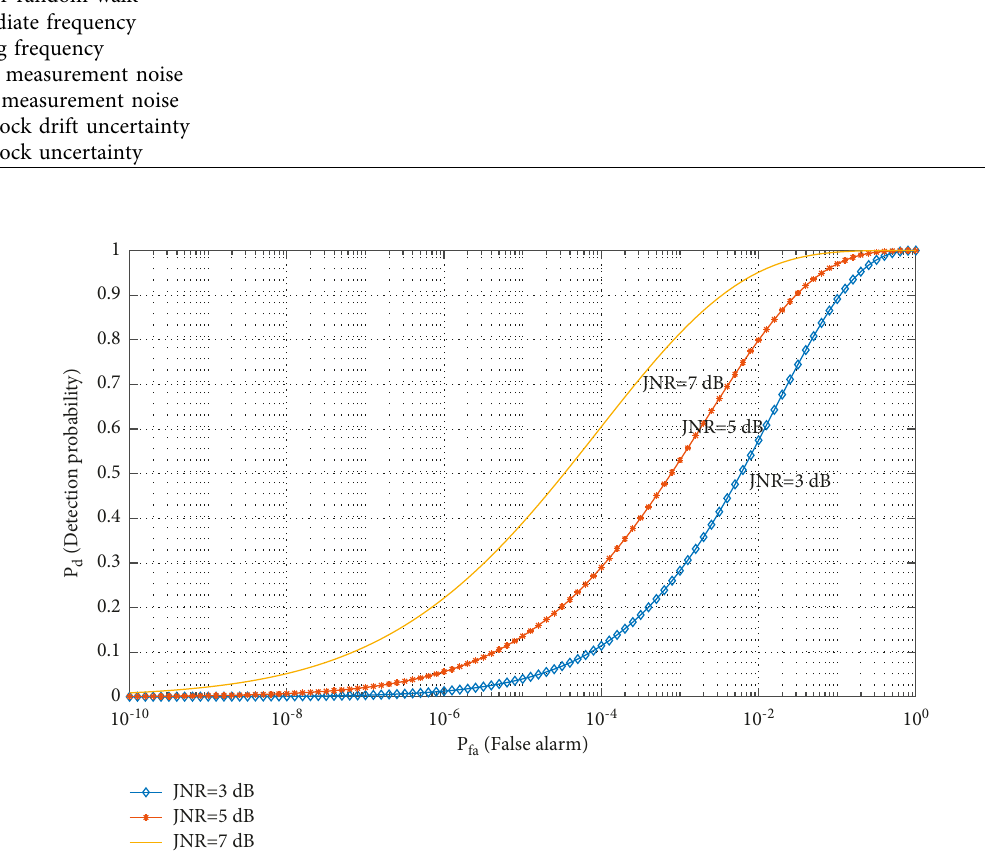
Figure 6: ROC with the JNR � 3dB, 5dB, and 7dB,